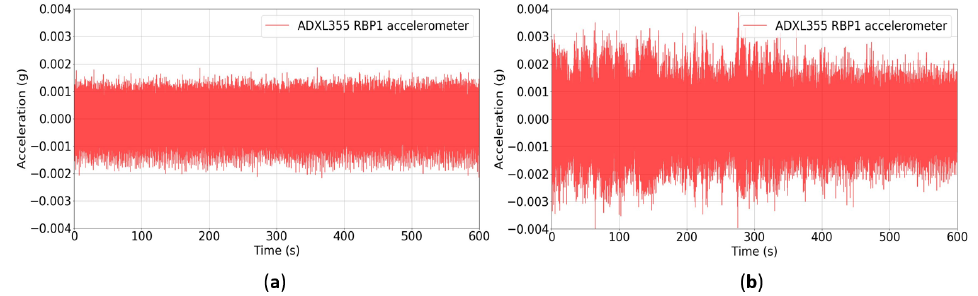
Figure 23. Vibration response from the span 1–2: ( a ) Ambient vibration record. ( b ) Forced vibration record during demolition